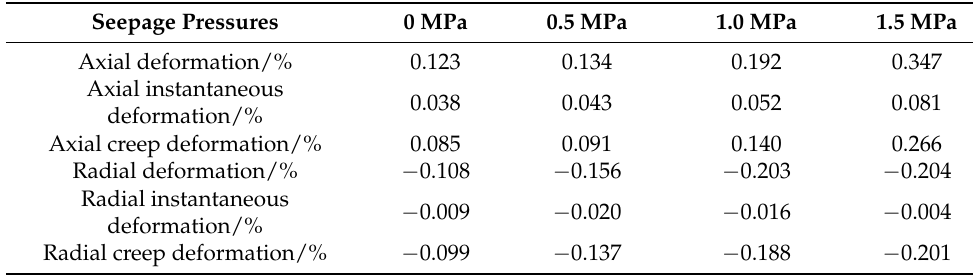
Table 1. Creep strain under different seepage pressures.